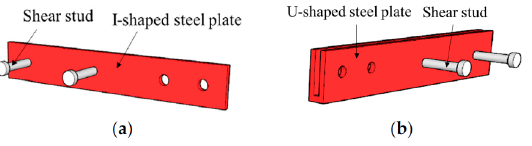
Figure 3. Steel plates: ( a ) I-shaped steel plate; ( b ) U-shaped steel plate.